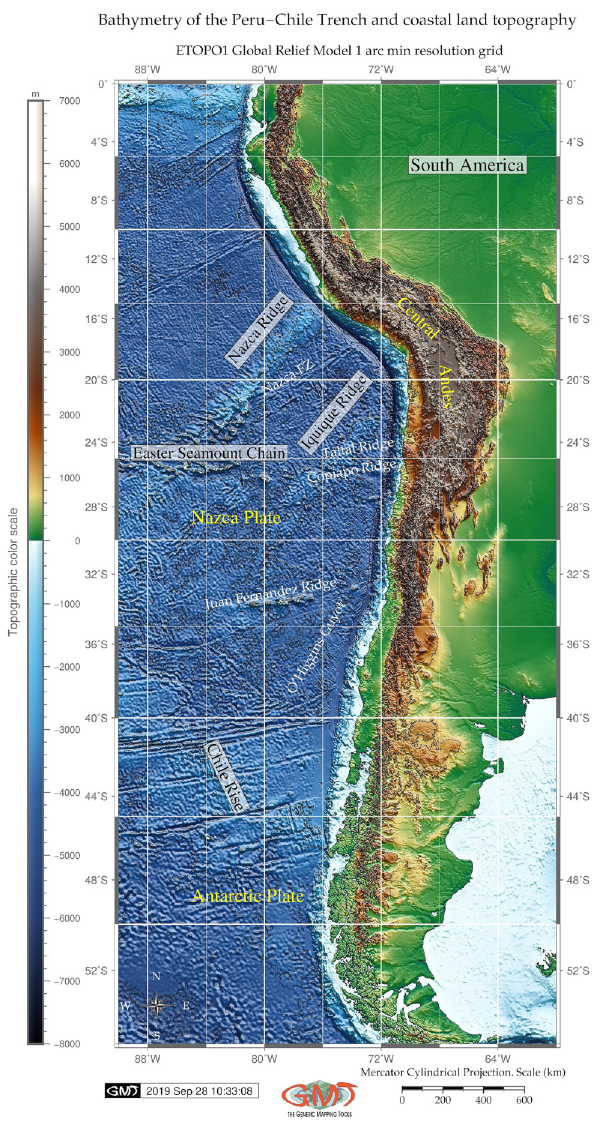
Fig. 1. Bathymetric map of the Peru-Chile Trench area. Topographic base map: